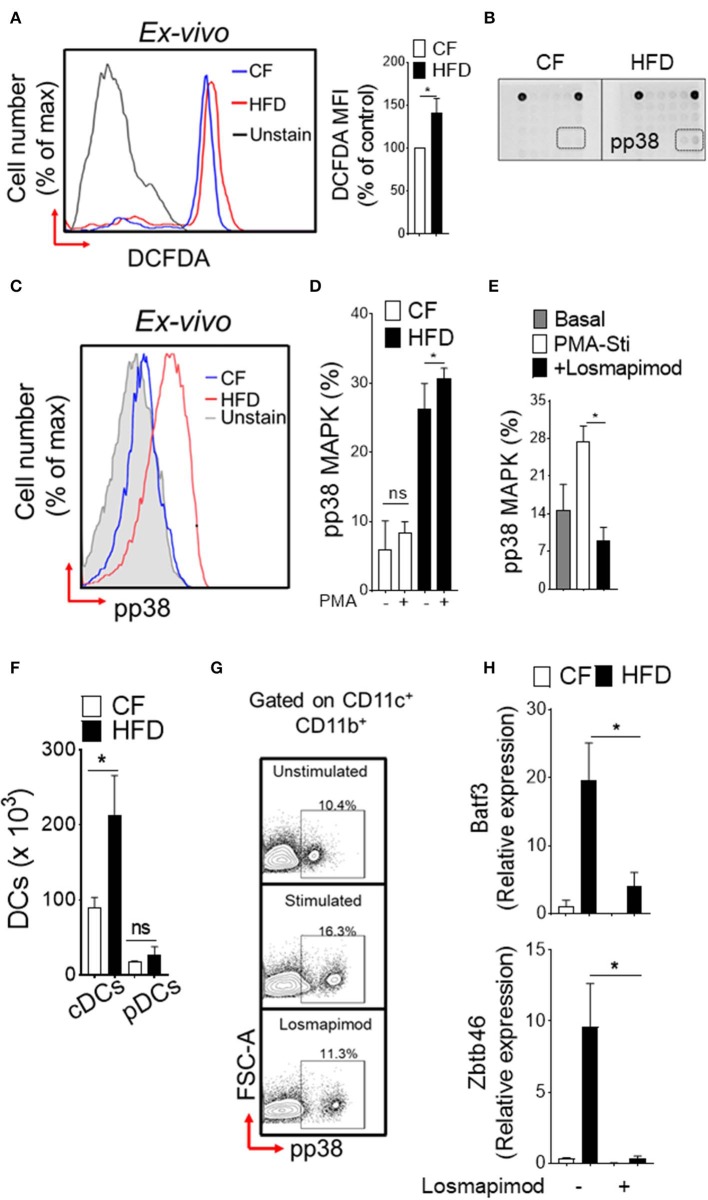
Induction of p38 MAPK in DC restricted precursor is associated with obesity. (A) Representative FACS plots (left) and mean fluorescence intensity (MFI) ± s.e.m (right) showing endogenous reactive oxygen species (ROS) level in DC-restricted CDPs from CF and HFD as measured by redox sensitive probe CM-H2DCFDA. (B) The phosphorylation status of 18 different signaling proteins in purified CDPs by array hybridization. (C) Representative FACS plots and (D) bar graph of mean percentages showing basal and PMA-stimulated ex vivo levels of phosphorylated p38 in CDPs from CF and HFD mice. n = 5/group. Two independent experiments. (E) Bar graph of mean percentages of pp38 MAPK in CDPs isolated from HFD and cultured in presence of losmapimod (20 μM). n = 4 biological replicate. Results are expressed as mean ± s.e.m. one-way ANOVA with Sidak's multiple comparison test *p < 0.05. (F) Numbers of splenic DCs subset in CF and HFD mice and (G) representative FACS plots of cultured DCs from HFD mice. Isolated DCs were treated with potent p38α/β MAPK inhibitor losmapimod (20 μM) and gated on CD11c+ CD11b+ cells. (H) qRT-PCR analyses of lineage-specific transcription factors in DCs isolated from CF and HFD mice. Data represents fold change ± s.e.m normalized to GAPDH expression. Three sets of independent experiment. One-way ANOVA with Sidak's multiple comparison test *P < 0.05.